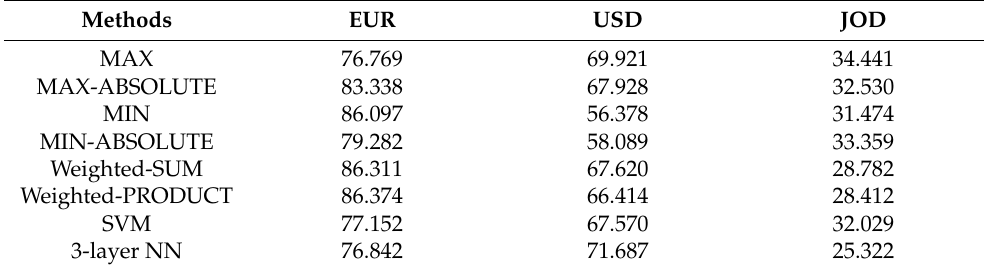
Table 7. Experimental results of training on KRW and testing on the other currency types using the proposed fusion methods on two additional CNN classifiers. (Measure: mAP, unit: %).